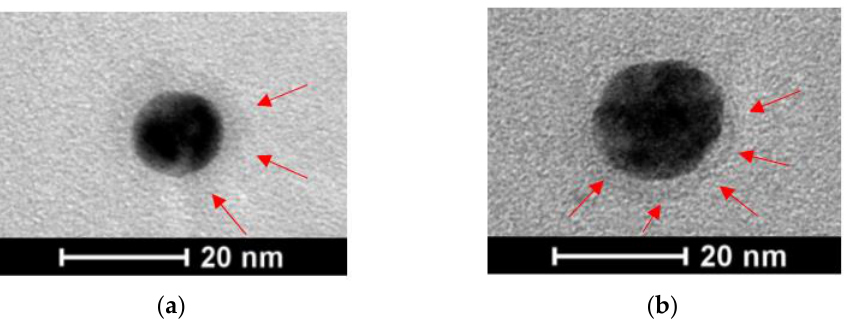
Figure 3. Appearance of thin organic shell around metal nanocore corresponds to ( a ) CS/TA/AgNPs (2-Ag) and ( b ) to CS/GA/TA/AgNPs (3-Ag) individual nanoparticles.